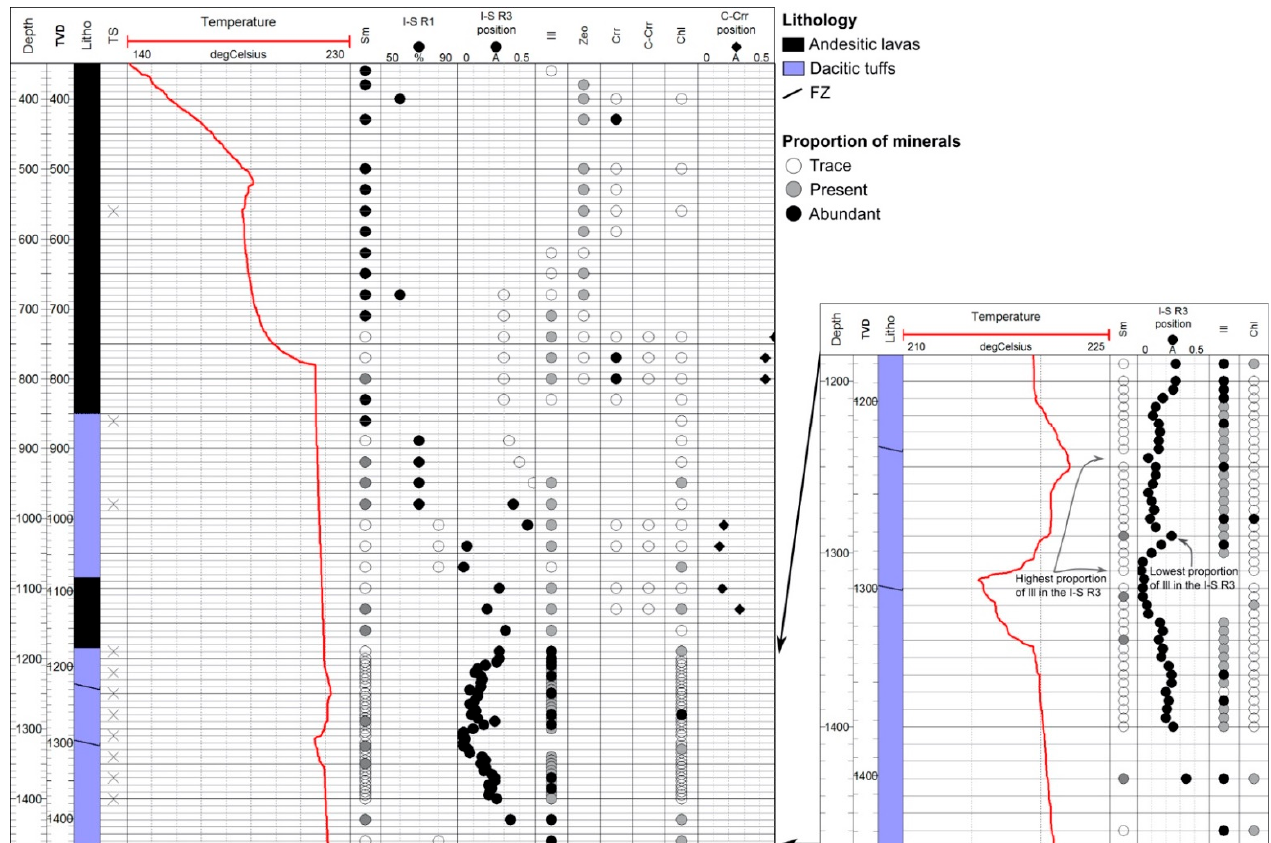
Figure 6. Relative proportion of clay mineral with depth estimated from EG-saturated XRD patterns within CP6A well with a close-up of the FZ shown on the right. The temperature profile was measured 4 months after drilling operations. I-S R3 and C-Crr positions are expressed in Ångstrom. I-S R1 are expressed in percentage of illite comprised between 60 and 80%. Depth: Measured Depth (m), TVD: True Vertical Depth, Litho: Lithology, TS: Thin Section, Sm: smectite, I-S: illite/smectite mixed layers, Ill: illite, C-Crr: chlorite/corrensite mixed layers, Crr: corrensite, Chl: